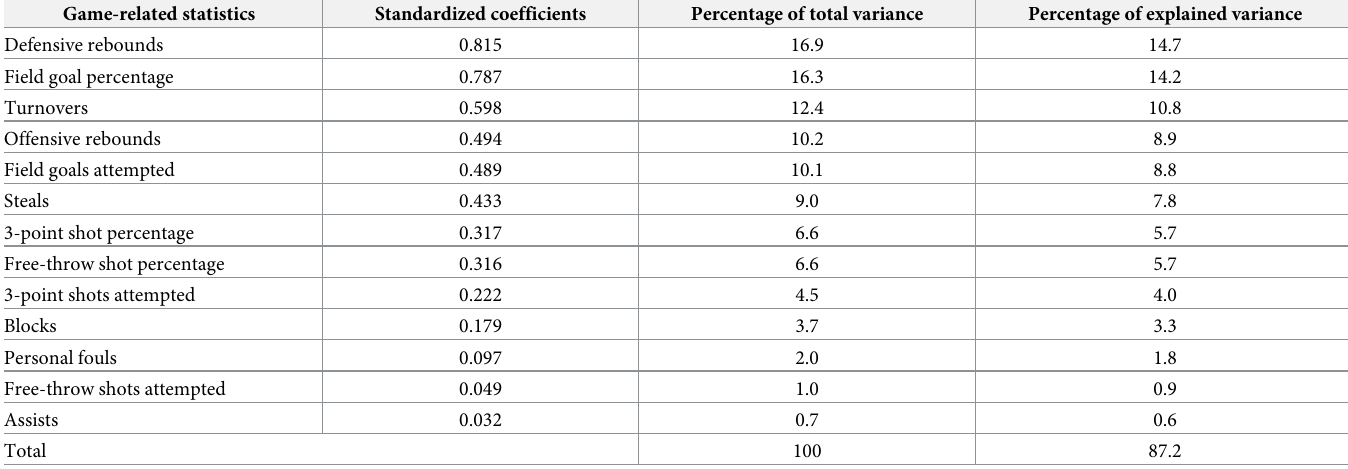
Table 6. Standardized discriminant function coefficients, percentage of explained and total variance for game-related statistical parameters during the post-season competitive period. Game-related